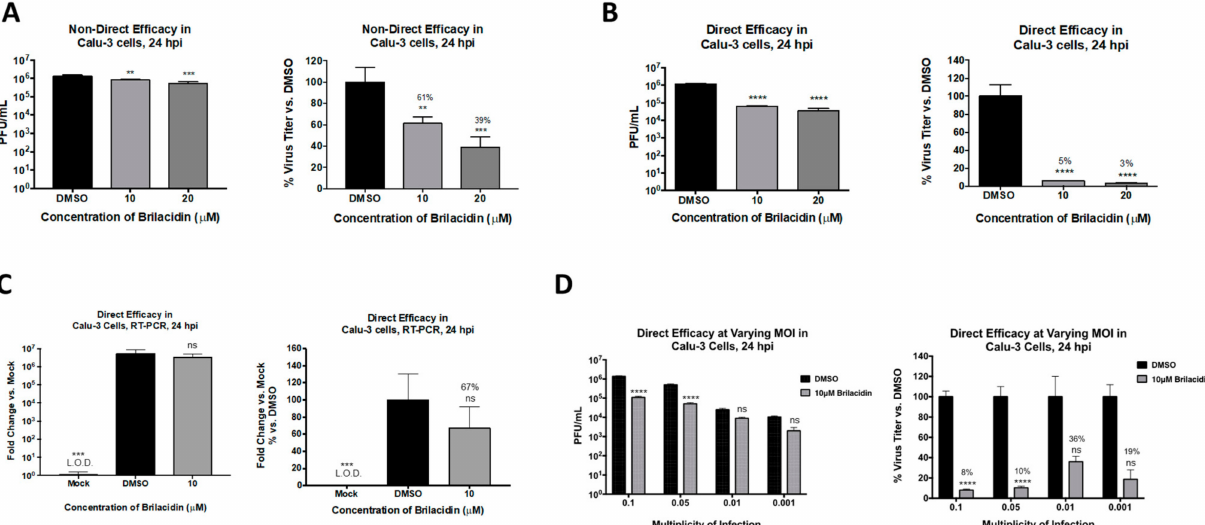
Figure 3. Brilacidin exhibits potent inhibition of SARS-CoV-2 in an ACE2-positive human lung cell line (Calu-3 cells). ( A ) Calu-3 cells were pretreated for 2 h with 10 or 20 µ M brilacidin and infected with SARS-CoV-2 at MOI 0.1 nondirectly or ( B , C ) directly with brilacidin for 1 h as described in Materials and Methods. Cells were post-treated with media containing brilacidin, and at 24 hpi, viral supernatants were evaluated by plaque assay ( A , B ) or intracellular RNA extracted and viral RNA quantified by RT-PCR ( C ) as described in Materials and Methods. ( D ) Calu-3 cells were pretreated for 2 h with 10 µ M of brilacidin, infected with SARS-CoV-2 at MOIs of 0.1, 0.05, 0.01, or 0.001 directly with brilacidin at 10 µ M for 1 h, and post-treated with media containing brilacidin as described in Materials and Methods. At 24 hpi, viral supernatants were evaluated by plaque assay as described in Materials and Methods. Statistical analyses for varying MOIs was determined using Two-Way ANOVA with Sidak’s multiple comparisons test. Significance for all other graphs were determined as described in Materials and Methods. Graphs are representative of one independent experiment performed in technical triplicates ( n = 3). ** p < 0.0021, *** p < 0.0002, **** p < 0.0001, ns = not